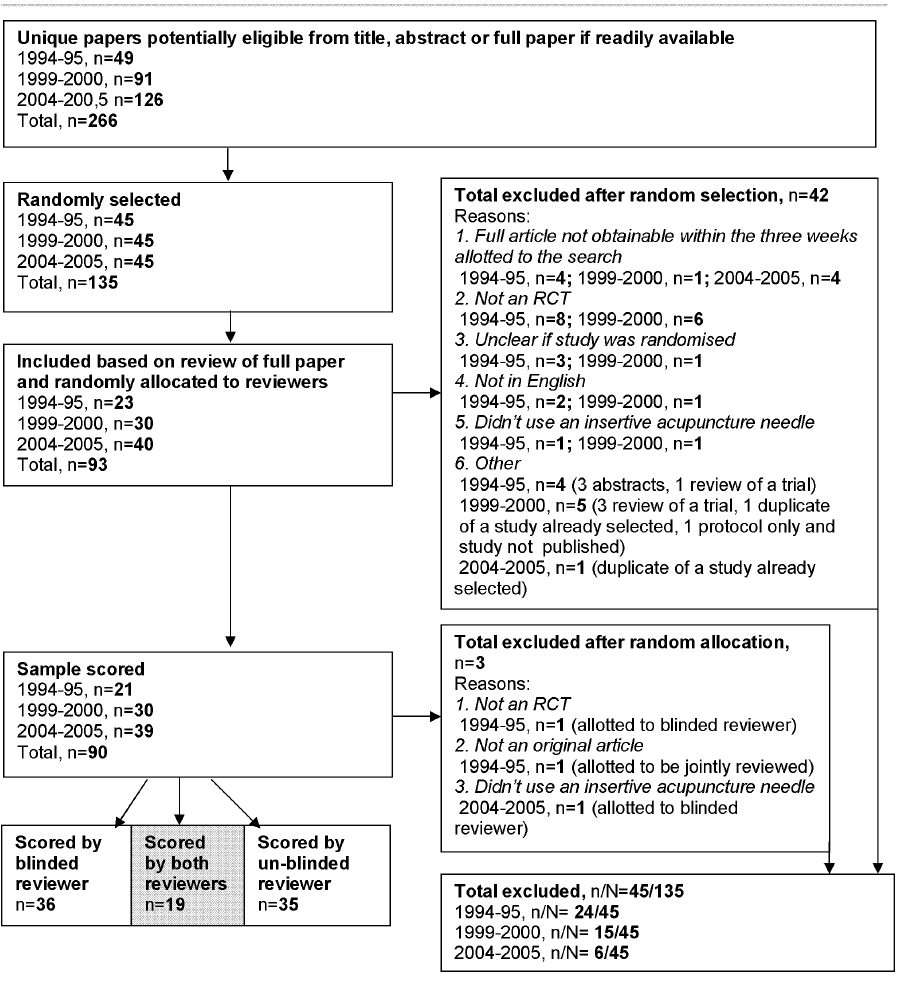
Figure 4. Flowchart.